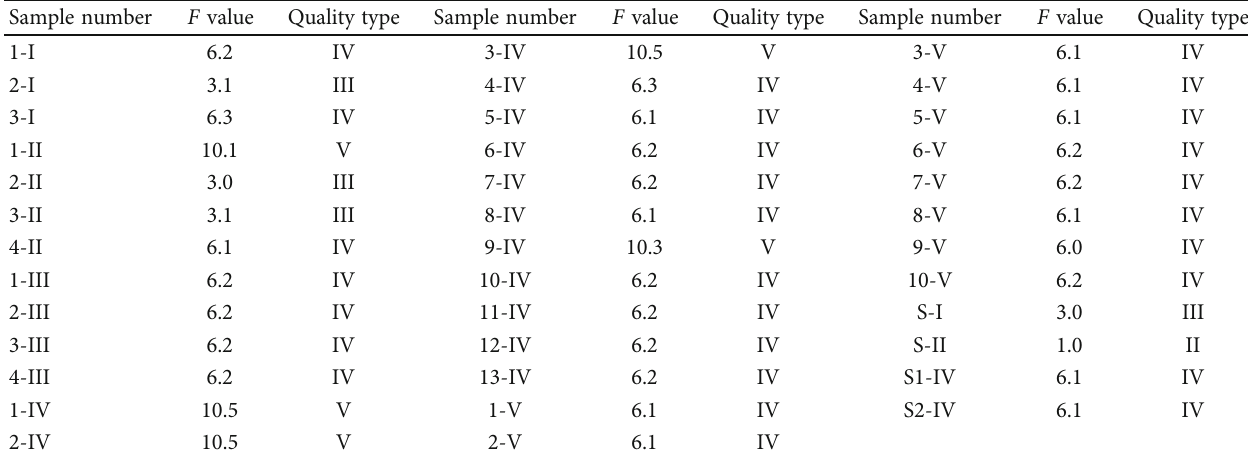
Table 4: Water quality evaluation results in the study